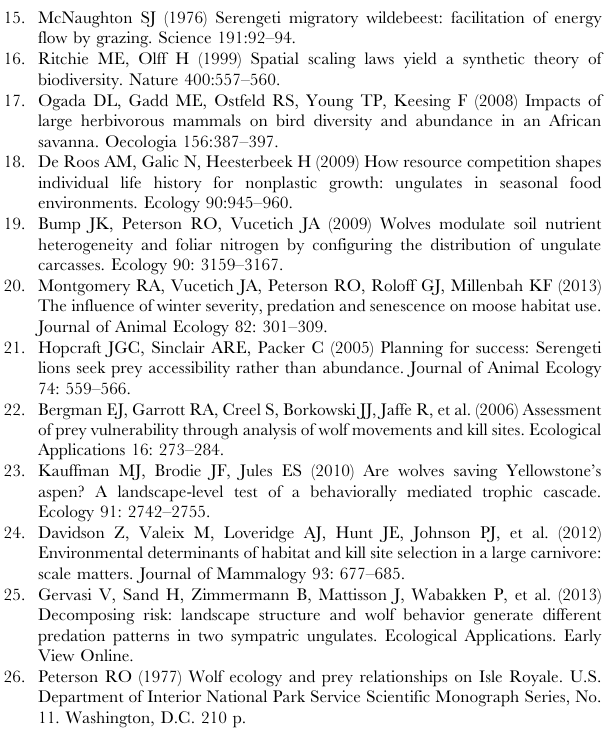
Figure S1 Standardized regression coefficients with standard error bars from the multiple linear regression model (with insignificant coefficients removed) describing habitat features at prime and senescent moose kill sites in Isle Royale National Park, Lake Superior, USA, 2000–2008. The response variable for this model was the percentile of the kernel density estimate (see Fig. 1) at each site where a moose was wolf-killed which depicts the probability of kill occurrence. Distance to shore refers to the Lake Superior shoreline, and distance to lake refers to inland lakes within Isle